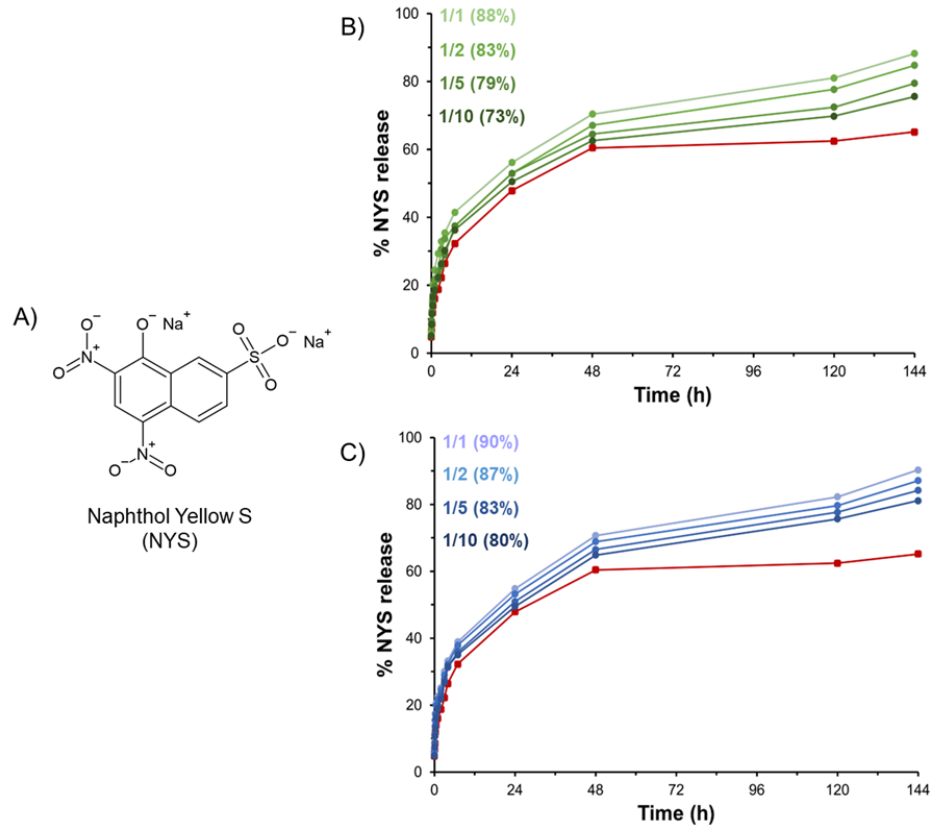
Figure 10. ( A ) Chemical structure of Naphthol Yellow S (NYS). Release profiles of NYS for Fmoc- FF/PEGDA1 ( B ) and for Fmoc-FF/PEGDA2 ( C ) hydrogels at different molar ratios. The NYS release from pure Fmoc-FF hydrogel is also reported for comparison (red line).